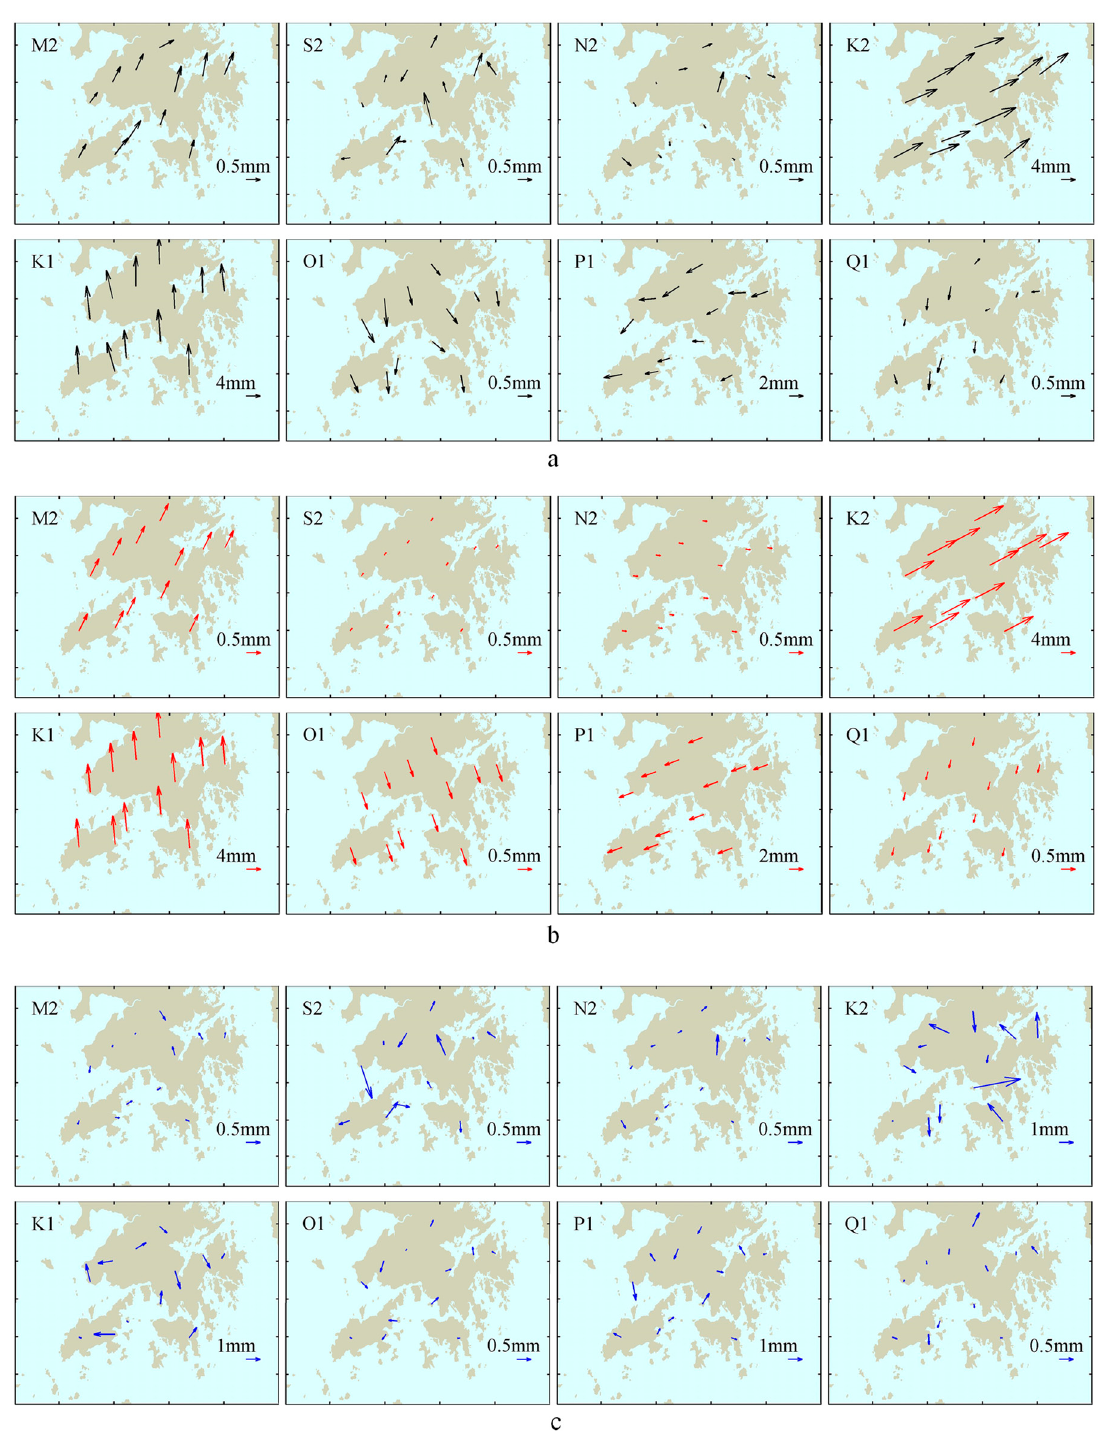
Figure 4. Spatial distribution of the phasor vector differences between the GPS estimates and the GOT4.10c + STW OTL model: ( a ) total phasor vector differences (black); ( b ) systematic phasor vector differences (red) estimated from ( a ); ( c ) residual phasor vector differences (blue) by ( a , b ).